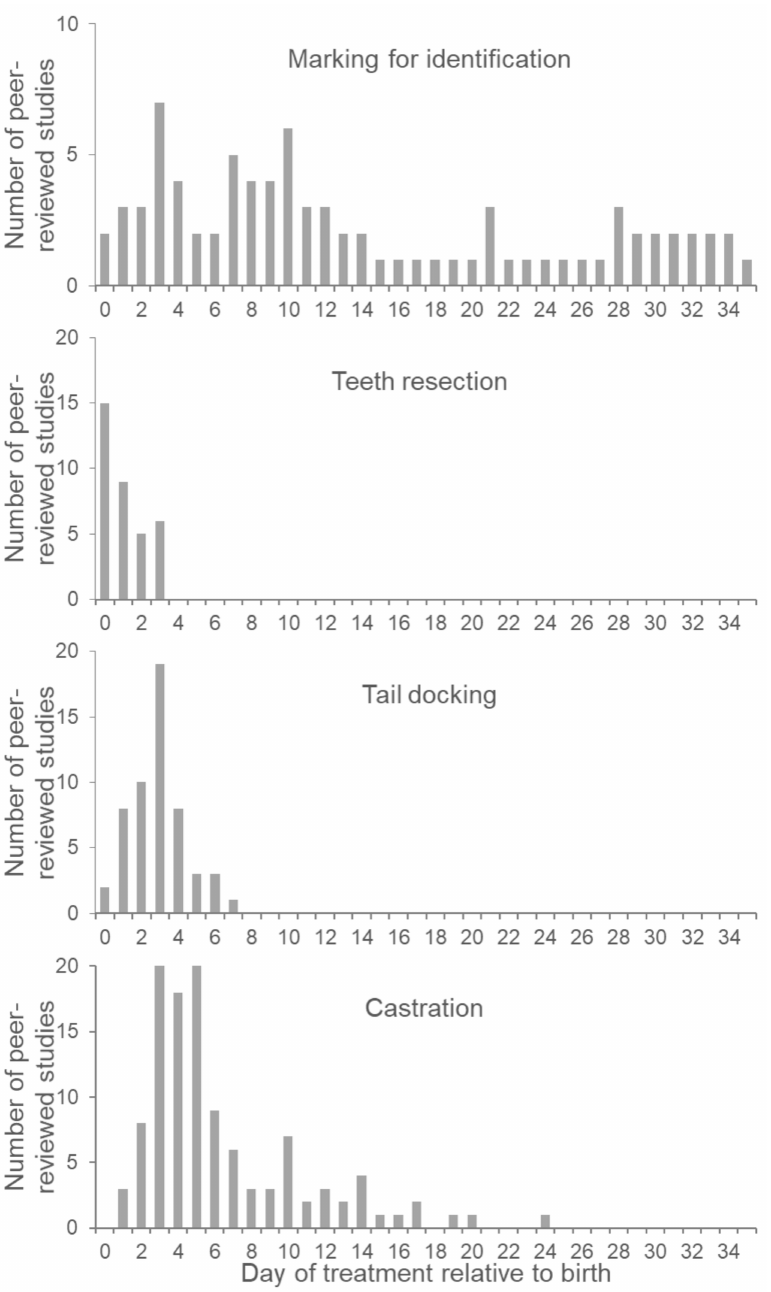
Figure 3. A frequency distribution of the timing of various processing treatments (marking for identification, teeth resection, tail docking, and castration) across the peer-reviewed studies included in this